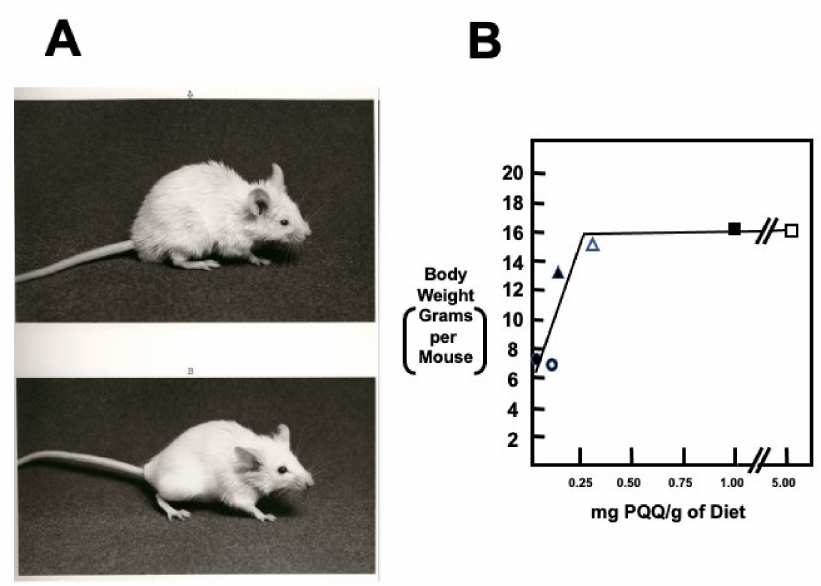
Figure 4. Growth and appearance of PQQ - deprived and - supplemented BALB/c mice . ( A , B ) are typical of a PQQ-deprived mouse and control mouse, respectively. Mice fed chemically defined diets devoid of PQQ grow poorly. Severely affected mice have friable skin, hair loss, and a kyphotic appearance. The graph indicates the growth of first-generation mouse pups born from BALB/c dams fed diets containing varying amounts of PQQ. The data suggests that a maternal and subsequent neonatal intake of approximately 300 ng PQQ/g of diet is required for optimal neonatal growth. Values are the means for a minimum of ten 6-week-old mice per. group. Additional details may be found in Steinberg et al.